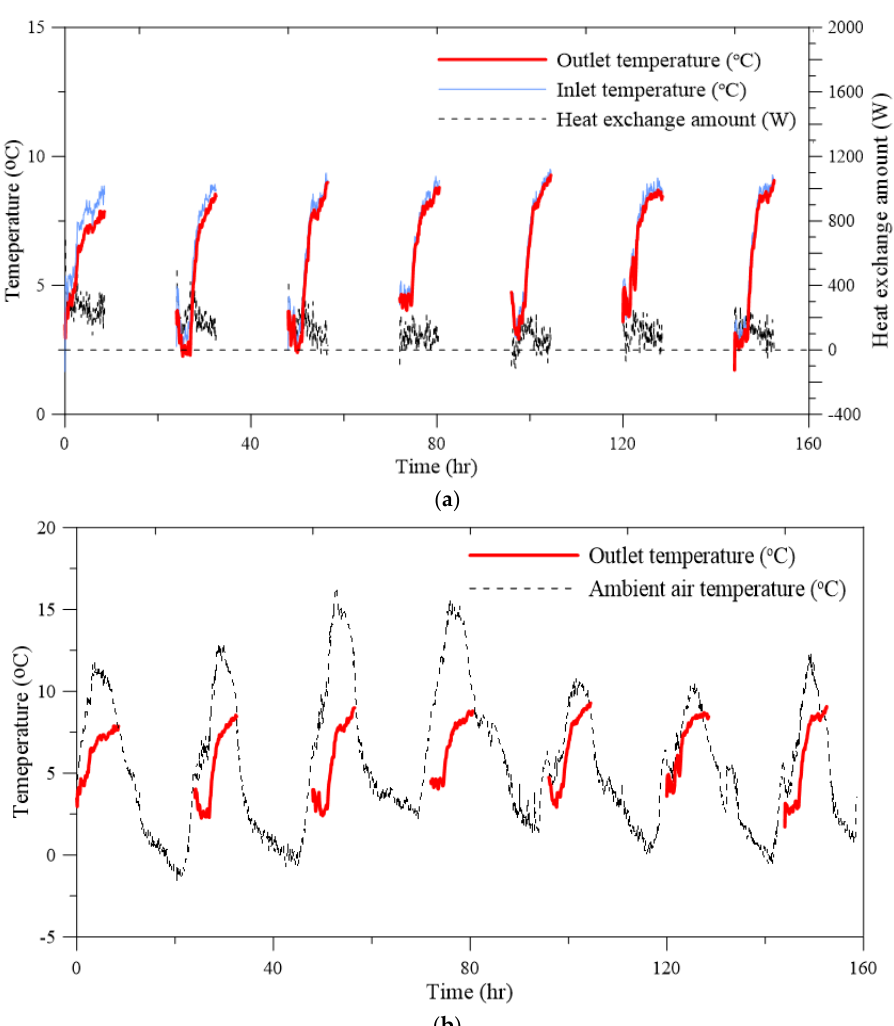
Figure 11. Thermal performance test (TPT) results of the wall-type energy slab with the high-density polyethylene (HDPE) pipe (without thermally insulation). ( a ) Inlet, outlet temperature and heat exchange amount; ( b ) Outlet and ambient air temperature.